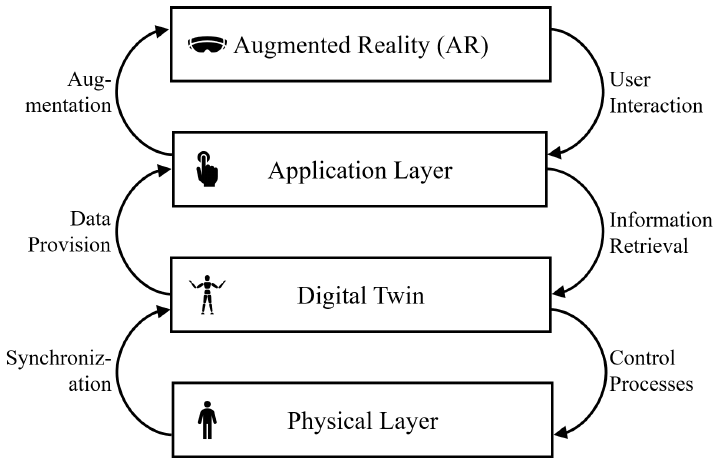
Figure 5. Derived layered architecture for AR-DT